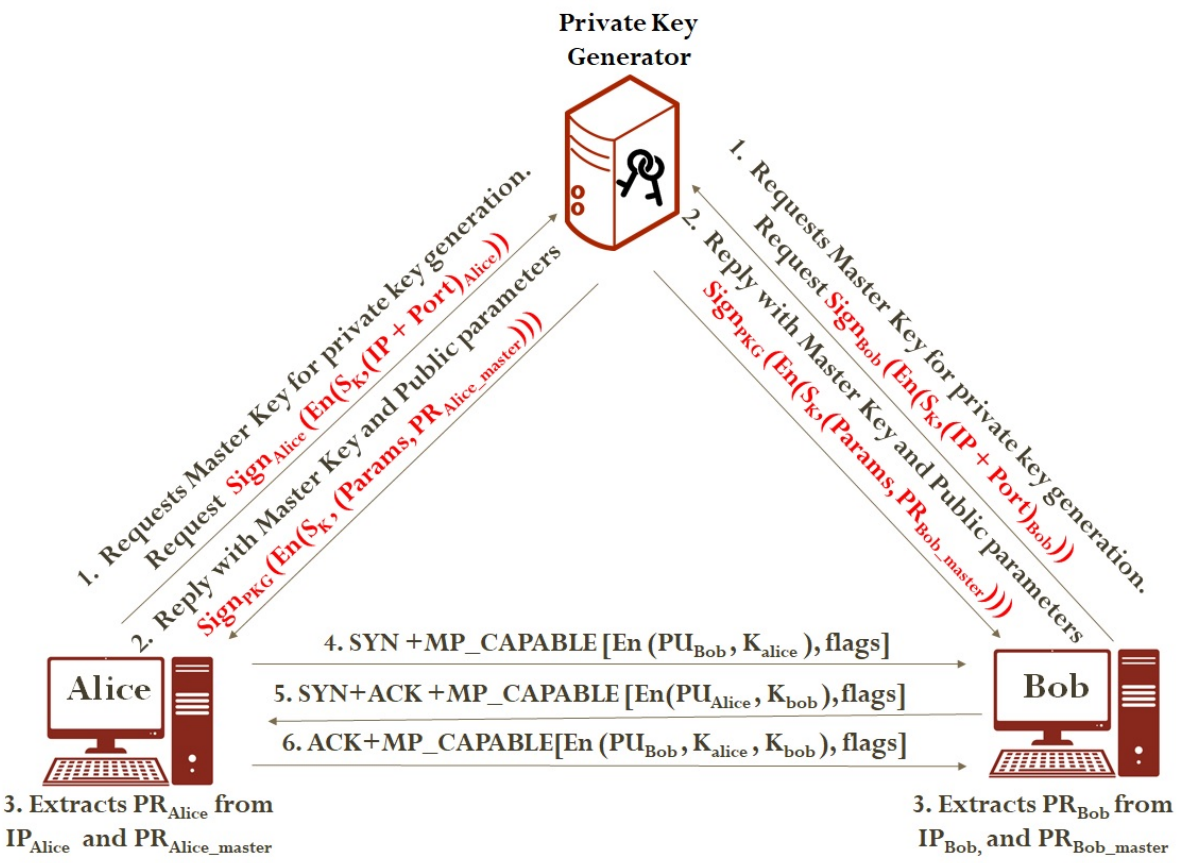
Figure 12. Secure key exchange during a three-way handshake using IBE.